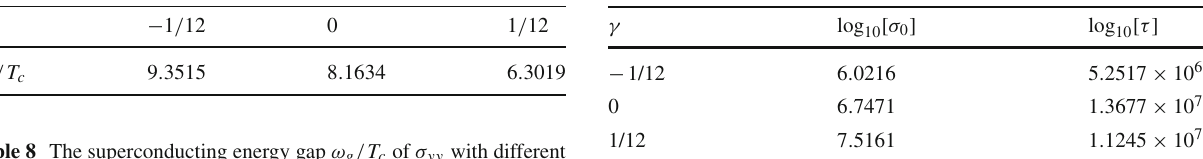
Table 7 The superconducting energy gap ω g / T c of σ yy with different γ . Here γ